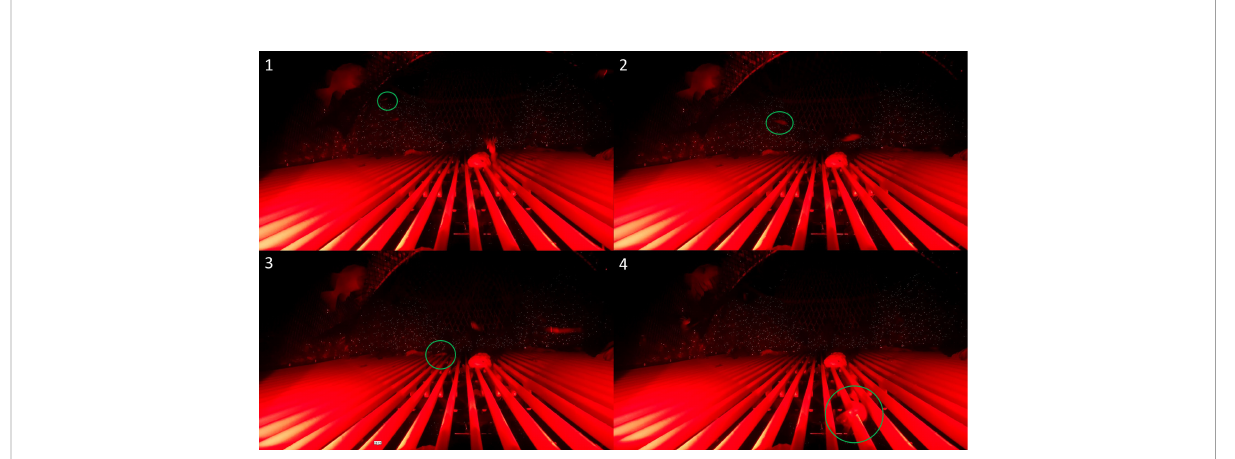
FIGURE 8 A behavioral sequence leading to retention. Underwater video screenshot of a red fi sh that exhibited sideways body orientation (1), upwards approach (2), contacted the grid (3), slid up the grid face until the fi sh orientated itself parallel to the grid, and passed through the bar spacings